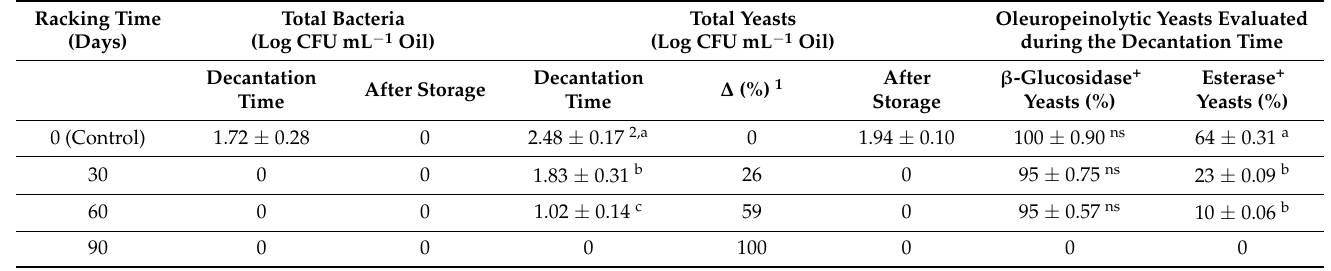
Table 3. Microbiological analysis of Coratina monocultivar EVOO during three months of decantation and after seven months of